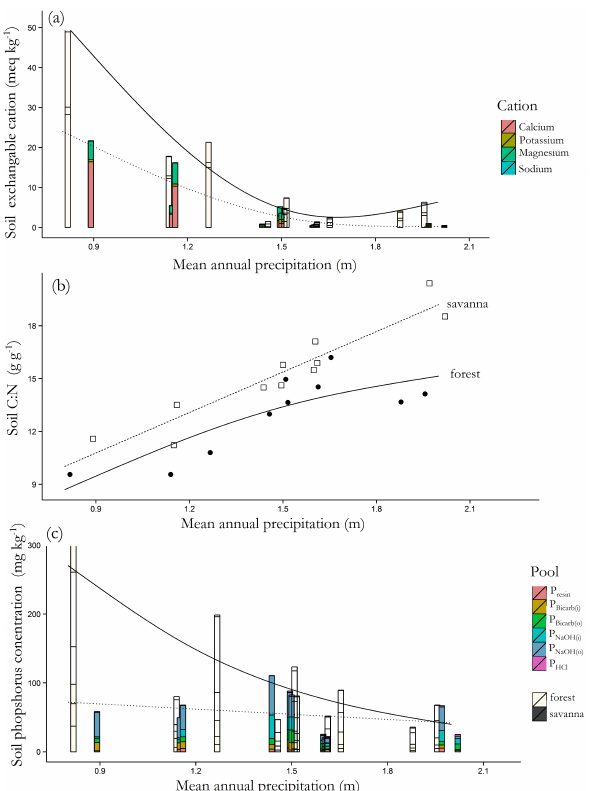
Figure 3. Variations in key soil chemical properties (0.0–0.3m depth) in relation to precipitation and vegetation formation type (a) soil exchangeable cations; (b) soil C / N ratio; (c) soil phos- phorus pools. For (a) and (b) forest plots are shaded more lightly than savanna with the fitted curves (solid for forest plots, dashed for savanna) representing generalised additive model fits represent- ing for (a) total exchangeable cations (sum of bases) and for (c) total extractable phosphorus. In (c) the phosphorus pools are as per the Hedley fractionation procedure (see Sect. 2.3.3): [ P ] resin – resin extractable P; [ P ] Bicarb(i) – bicarbonate extractable in- organic phosphorus; [ P ] Bicarb(o) bicarbonate extractable organic phosphorus; [ P ] NaOH(i) – NaOH extractable inorganic phosphorus;